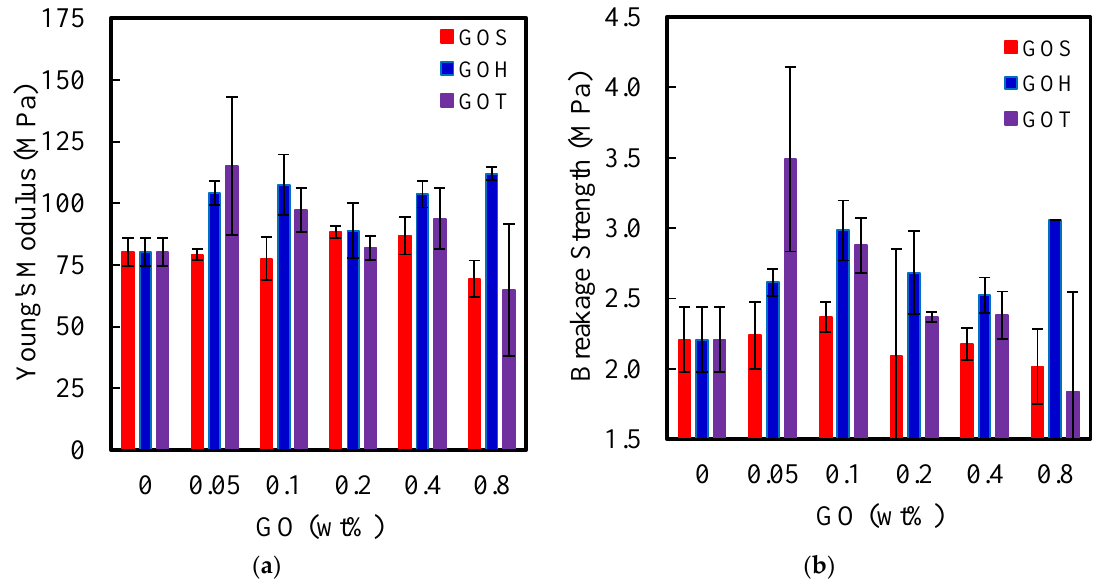
Figure 5. Effect of GO type and loading on ( a ) Young’s modulus and ( b ) breakage strength of GO-PSf membranes. Error bars show sample standard deviation.